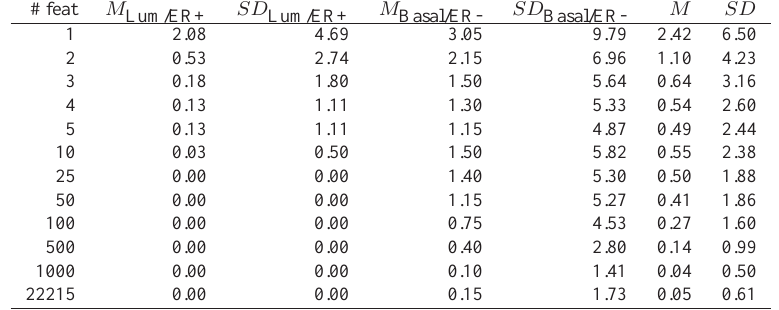
Table 1: Average Test Error ( M ) on the gene expression data for the Lum/ER+ vs. Basal/ER- task (global and classwise), with standard deviation ( SD